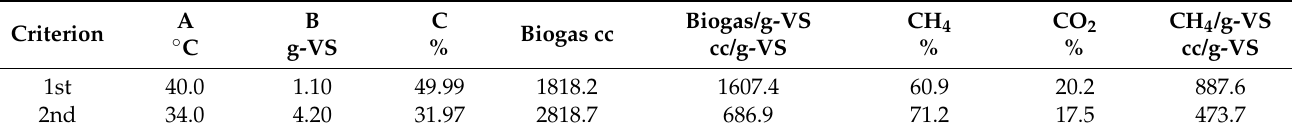
Table 17. The optimal results of the two criterions for extracted oil date